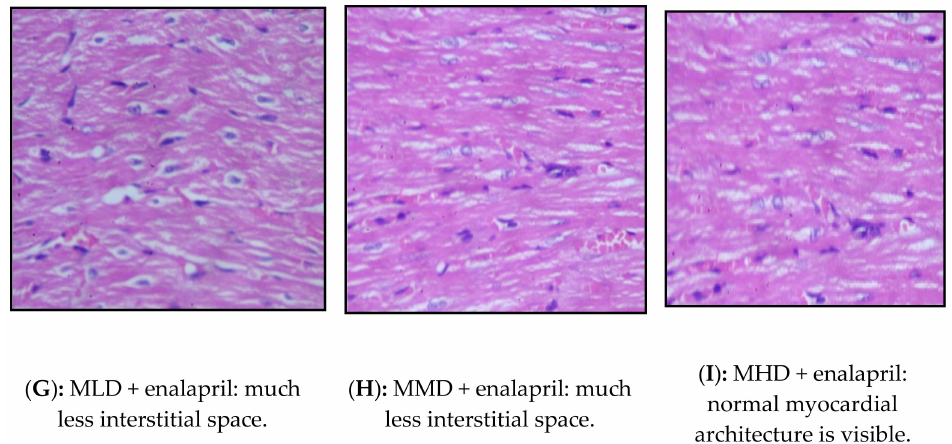
Figure 1. Hematoxylin and eosin ( H & E )-stained section of the heart in isoprenaline-induced acute myocardial damage. Photographed at a magnification of 400 × .